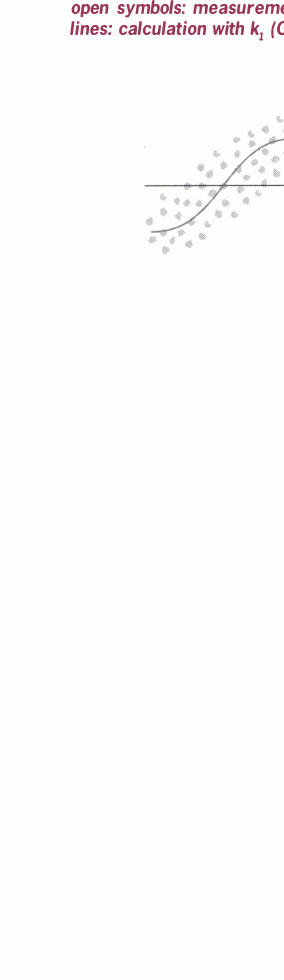
Abb. 2: Zusammenhang zwi­ schen relativer Viskositiit und Feststoffkonzentration bei verschiedenen Scherzeiten Relative Viskositiit - .Scher­ vorgeschichte" 1 = 1 ()3 s-1 2 % wii6rige Xanthan Losung + CaC03 Fiillstoff offene Symbole: Messung Linien: Rechnung mit k1 (C ,} Fig. 2: Relation between rela­ tive viscosity and solids content for different shear times ralative viscosity - "shear history" ('1 = 1()3 s-1 } 2 % xanthane aqueous solution + CaC03 filler open symbols: measurement lines: calculation with k1 (C,J